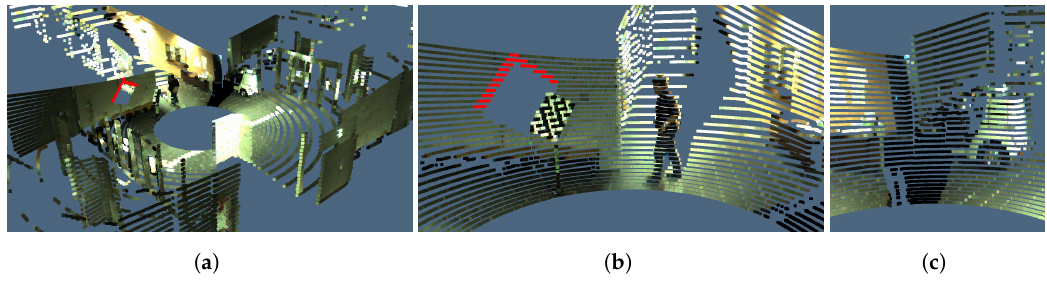
Figure 20. Zoomed details of re-projected points. ( a – d ) Re-projected results on chessboard, human, pillar and car respectively. Each column represents re-projected points colored by intensity and distance on original RGB images and edges-extracted images. Blue indicates low value and red indicates high value.